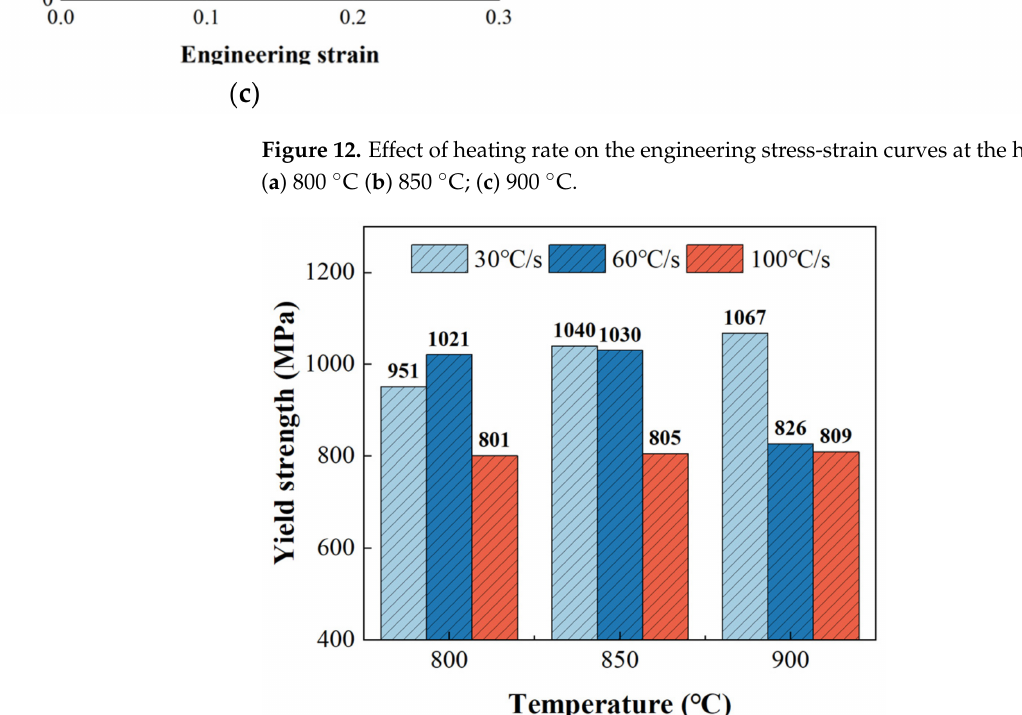
Figure 13. Yield strength after cooling at a cooling rate of 200 ◦ C/s at different heating temperatures and